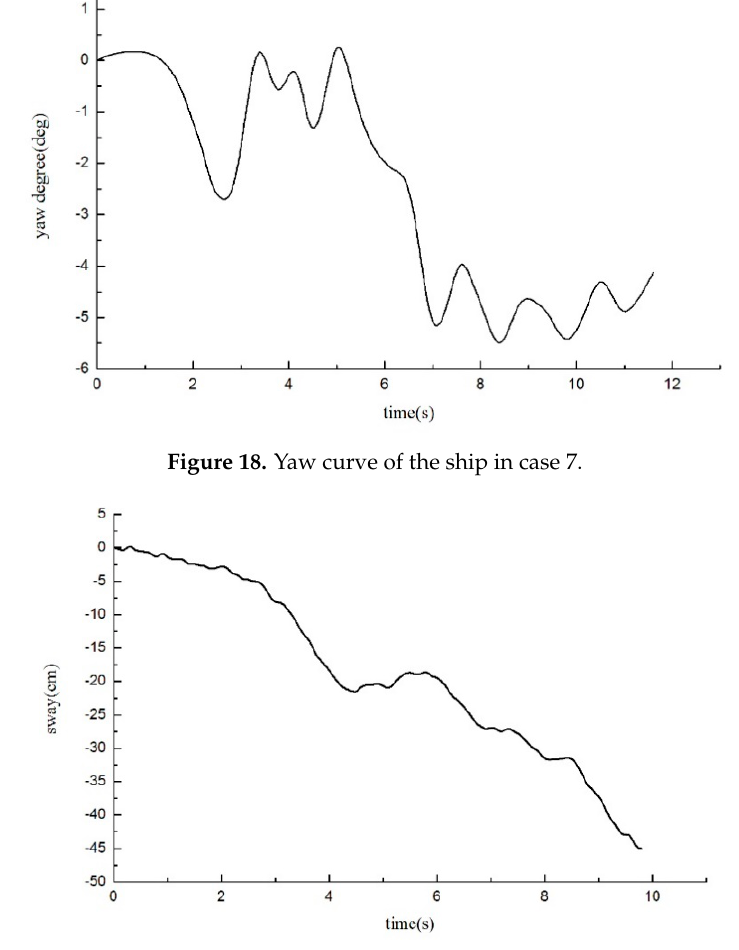
Figure 19. Sway curve of the ship in case 7.